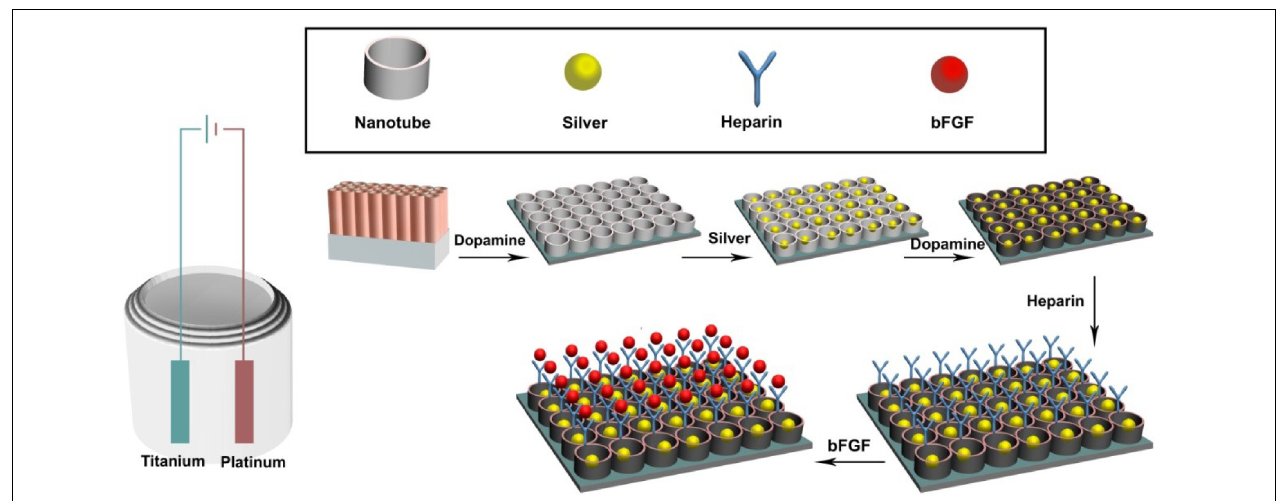
FIGURE 1 | Experimental design of the in vitro experiments. The titanium sheet was cut into the size of 1 cm × 1 cm pieces. Then the titanium surface was modified to titanium nanotube, coated with dopamine, and cross-linked with heparin and basic fibroblast growth factor